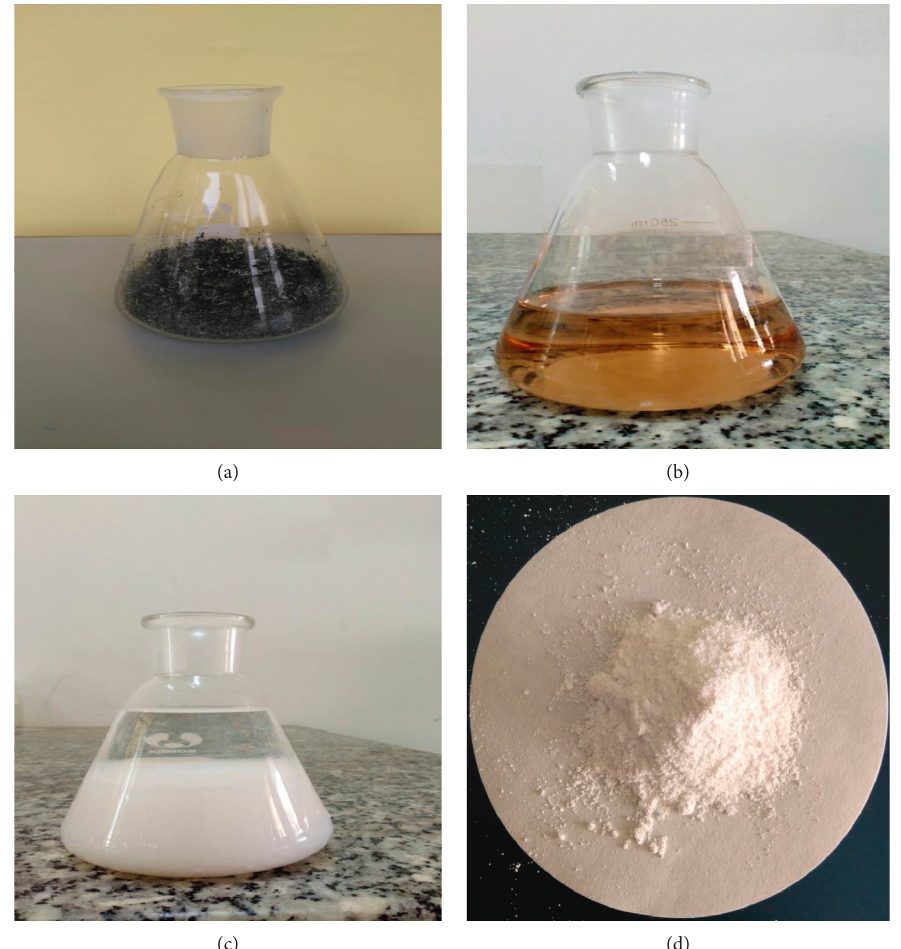
Figure 1: Extraction process of SiO 2 from rice husk ash. (a) Rice husk ash from brick industry. (b) Rice husk ash diluted in sodium hydroxide after filtering. (c) Rice husk ash solution after precipitation by acid. (d) Extracted SiO 2 after